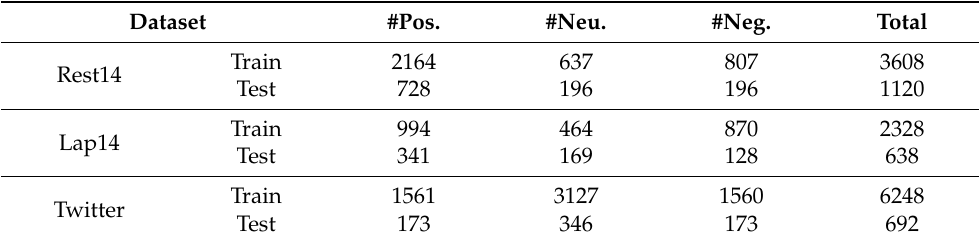
Table 1. Statistics of